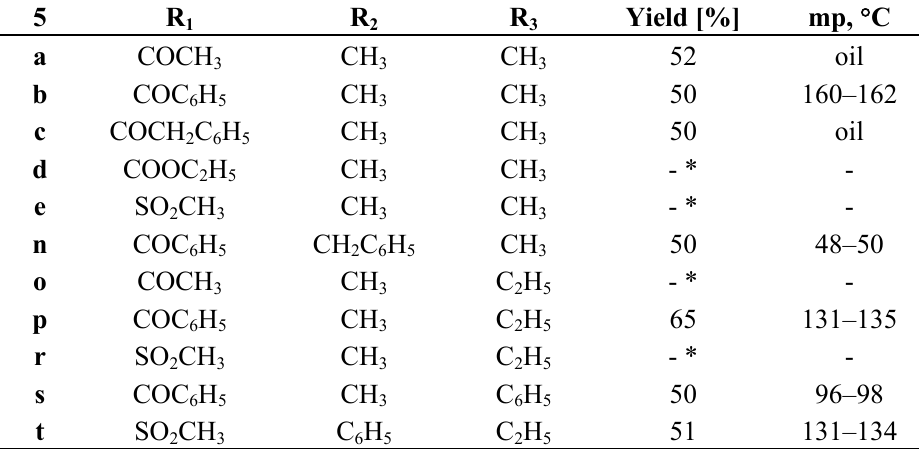
Table 3. Reaction of ketoamides with Grignard